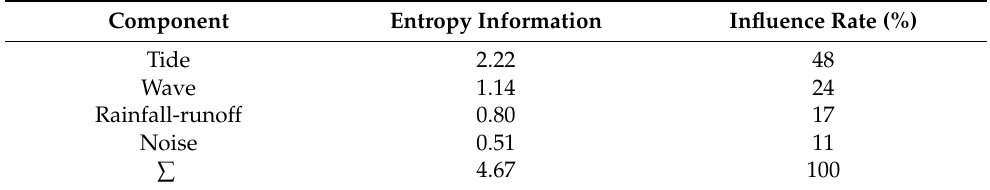
Table 2. Rate of influence for each